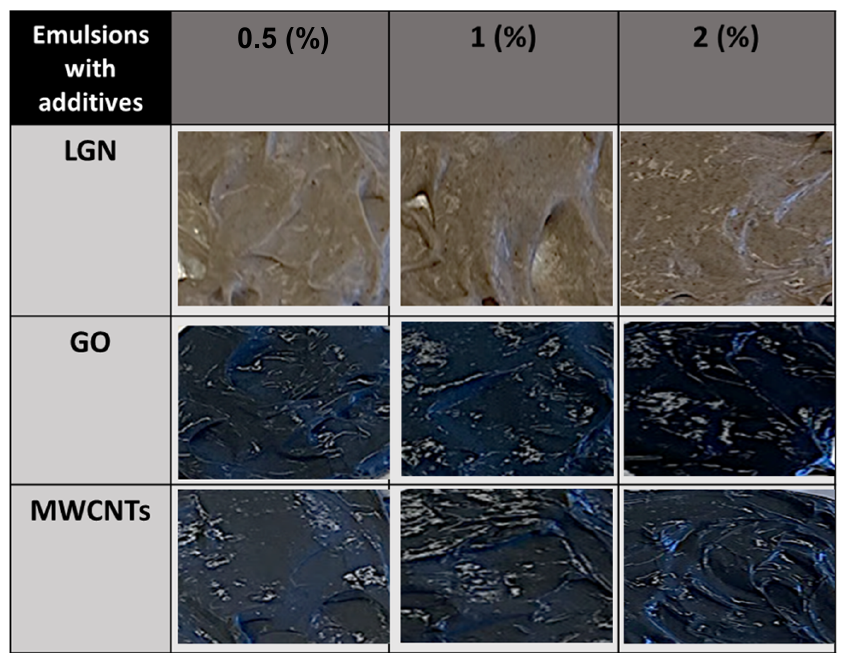
Figure 3. Samples of prepared O/W emulsions on aluminum foil before UV irradiation.